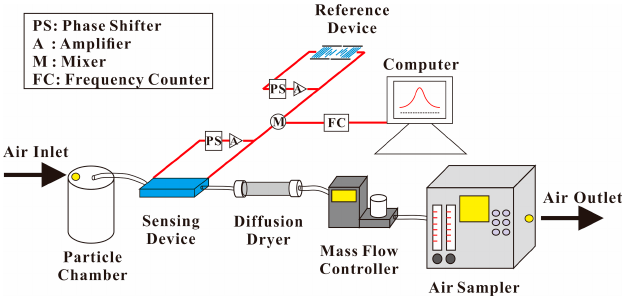
Figure 16. Experimental setup for evaluating the characteristics of the SAW based PM 2.5 sensor.